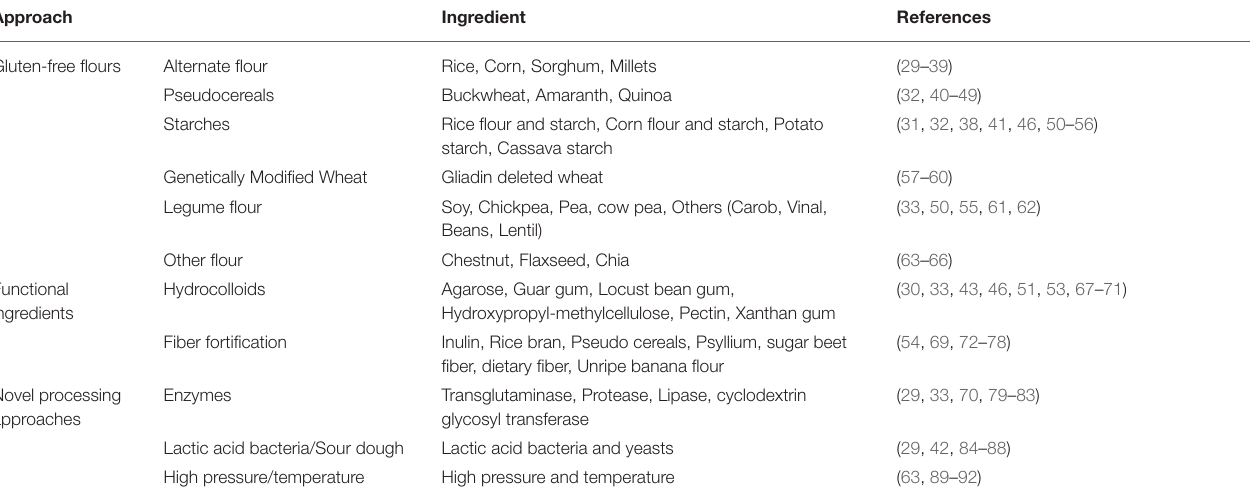
TABLE 1 | Research methodology along with references for developing new generation gluten-free